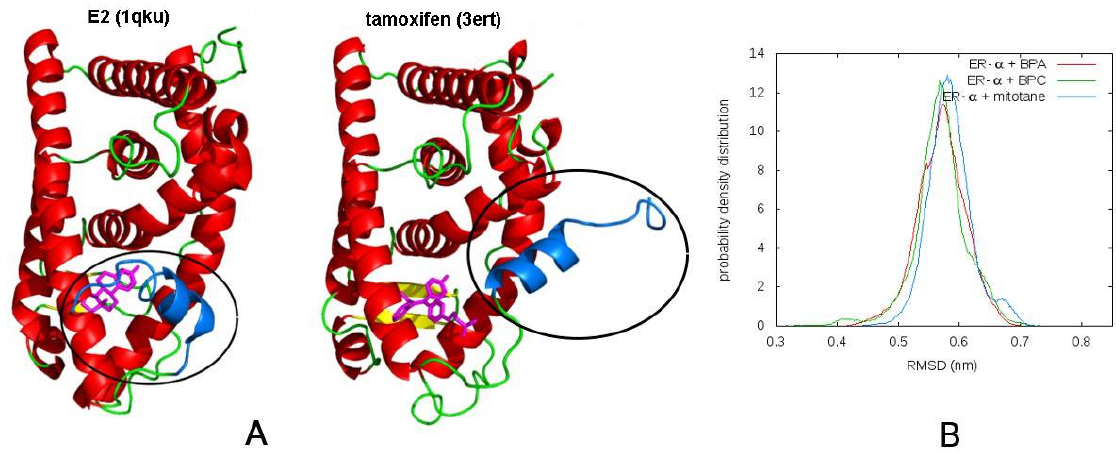
Figure 2. Conformation of active and inactive ER-α and comparison with MD results. ( A ) the active conformation of the ER-α receptor is represented on the left based on the 1qku structure, containing the receptor in complex with the natural ligand E2. The inactive form is represented on the right based on the 3ert structure, in complex with the tamoxifen inhibitor. The mobile H12 helix, crucial in the activation of the receptor, is represented in blue. The inhibitor compound displaces the H12 helix from the binding pocket, disrupting the cofactors binding surface; ( B ) probability density distribution of the RMSD of the backbone atoms with respect to the 3ert structure, obtained from the molecular dynamics simulations of the complexes of ER- α with BPA (red curve), with BPC (green curve) and with mitotane (blue curve). Table 1. Binding free energies in kcal/mol of different ligands with ER- α expressed as differences with respect to the value of